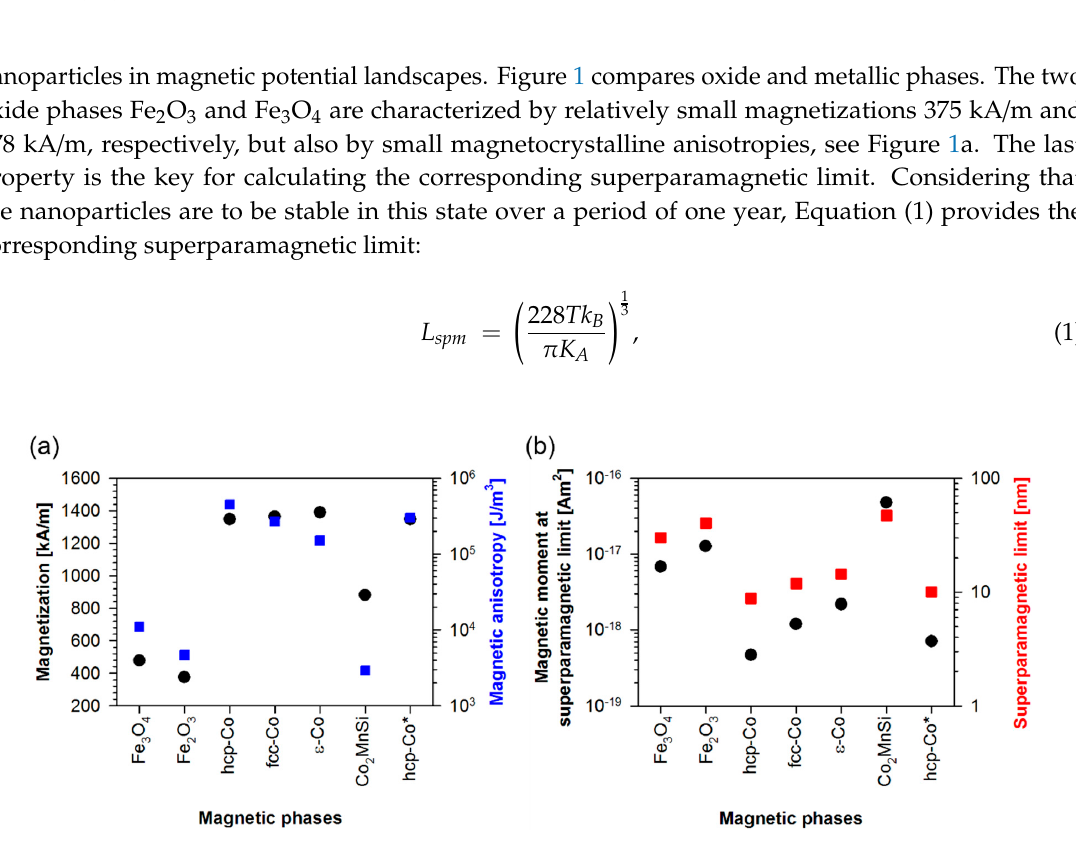
Figure 1. Intrinsic magnetic data of different phases taken from [30] for Fe 2 O 3 and Fe 3 O 4 , from [31,32] for hcp-Co, fcc-Co and ε -Co and from [33] for Co 2 MnSi. The hcp-Co phase marked by stars have magnetocrystalline anisotropies reduces by a factor of 1.5 due to grain size refinement of the underlying microstructure as is reported in [34]. ( a ) Comparison between saturation magnetization (black filled circles) and magnetocrystalline anisotropy (blue filled squares) at room temperature and; ( b ) Resulting superparamagnetic limits (red filled squares) calculated employing Equation (1) and the calculated magnetic moment at the superparamagnetic limits (black filled circles) considering spherical nanoparticles.